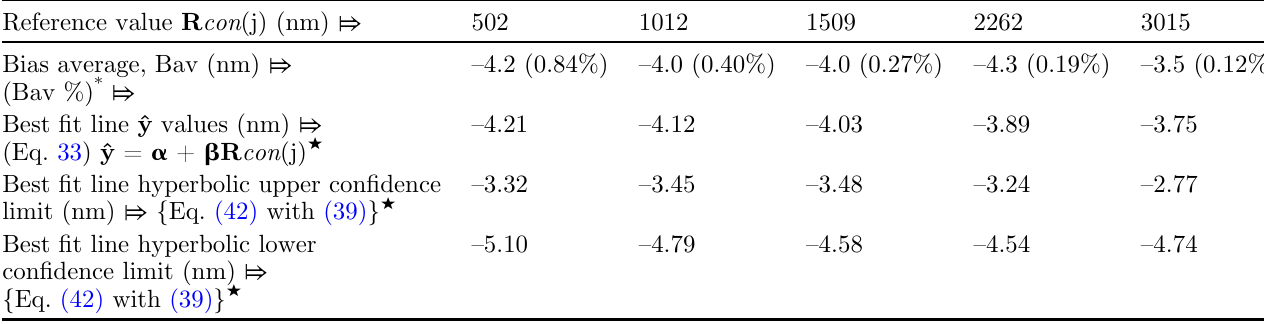
Table 10. Example 5. FAC-1; system C; linear regression analysis results; best fi t line.